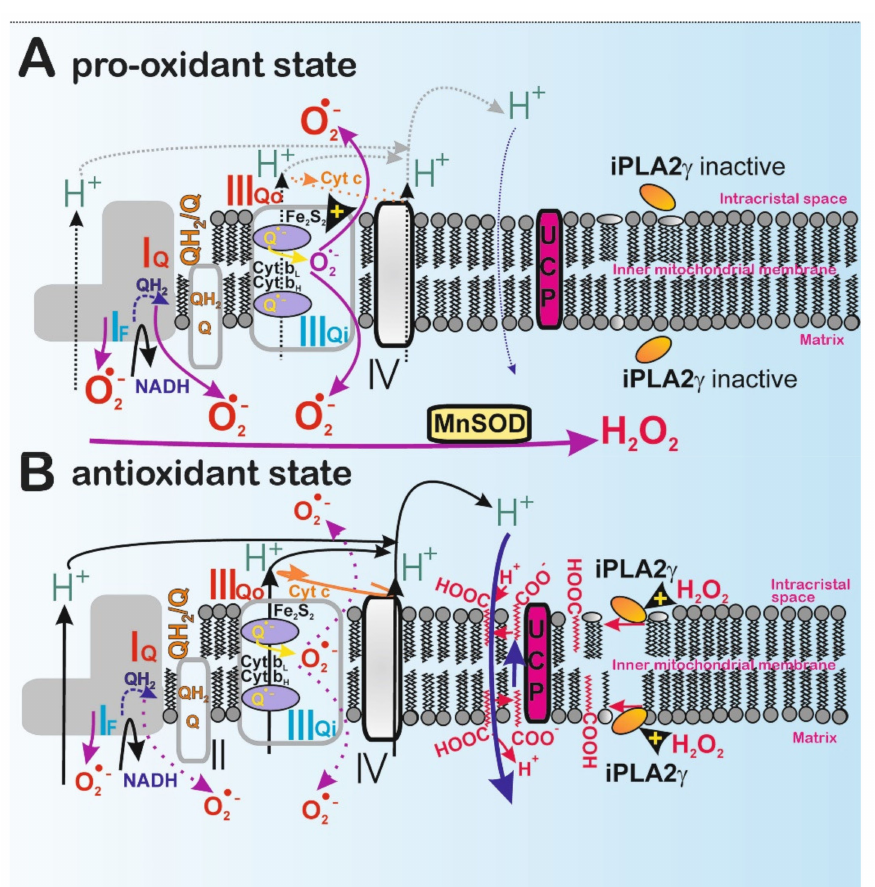
Figure 5. The antioxidant synergy of H 2 O 2 -activated iPLA2 γ and UCP2. ( A ) Pro-oxidant state: low respiration, slow H + pumping, and relatively highly coupled state of mitochondria can lead to higher superoxide formation, for example, at sites classified by M. Brand, such as Complex I flavin site I F , Complex I ubiquinone (Q) site I Q , and Complex III outer ubiquinone site III Qo [67]. In the absence of a mild uncoupling due to the lack of fatty acids, there is no additional acceleration of H + pumping and respiration. ( B ) Antioxidant state: accumulated H 2 O 2 (transformed from superoxide by MnSOD) activates the mitochondrial phospholipase iPLA2 γ , which subsequently cleaves FAs from phospholipids and cardiolipin of the IMM. The nascent FAs bind to UCP2 and are exported as FA anions from the inner (matrix side) to the outer (crista lumen) intracristal membrane phospholipid leaflet [47–49]. The subsequent protonation allows FA to cross the lipid bilayer by electroneutral diffusion (flip-flop) back to the matrix, releasing H + . Note that protons are not conducted by UCP but by protonated FAs. As a result, a moderate H + short-circuit of the IMM substantiates mild uncoupling, which immediately accelerates electron transport (respiration), leading to a decrease in superoxide formation